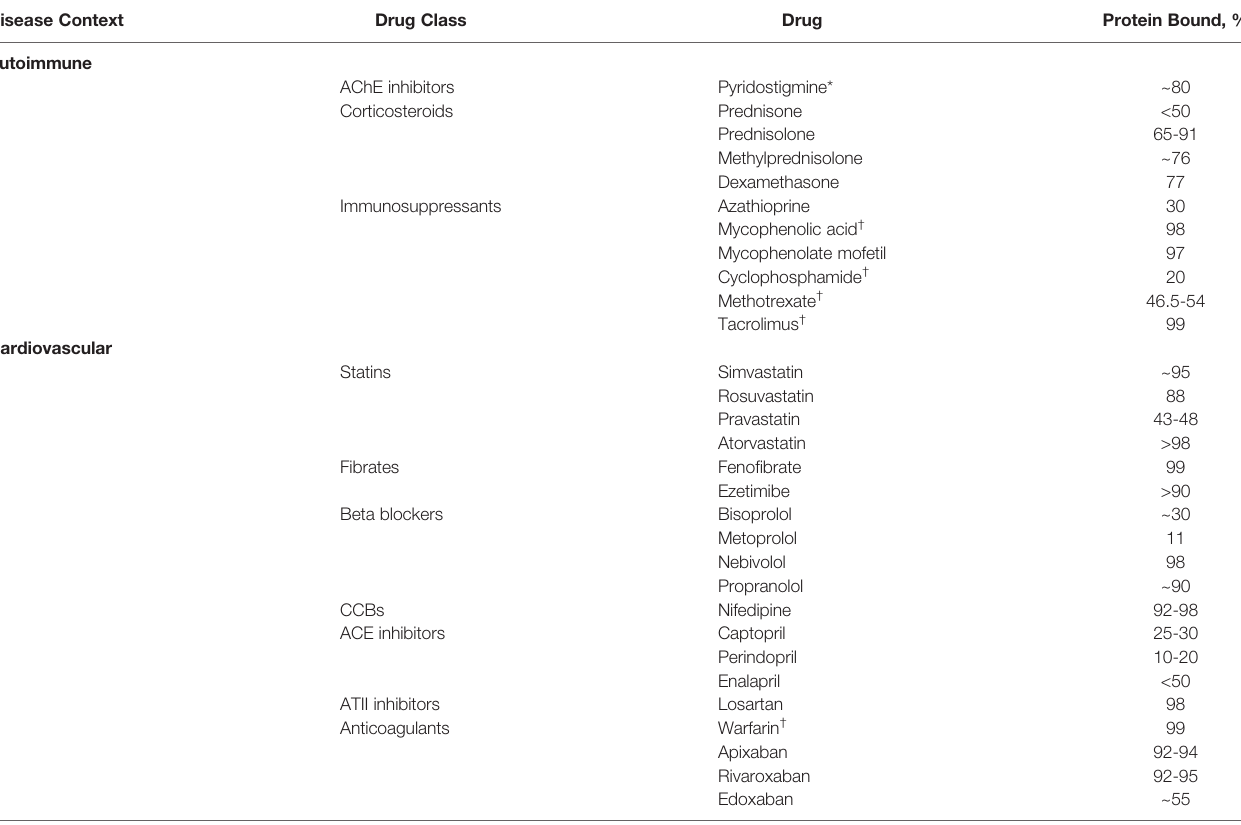
TABLE 1 | Protein binding of medications used in autoimmune and cardiovascular diseases. Disease